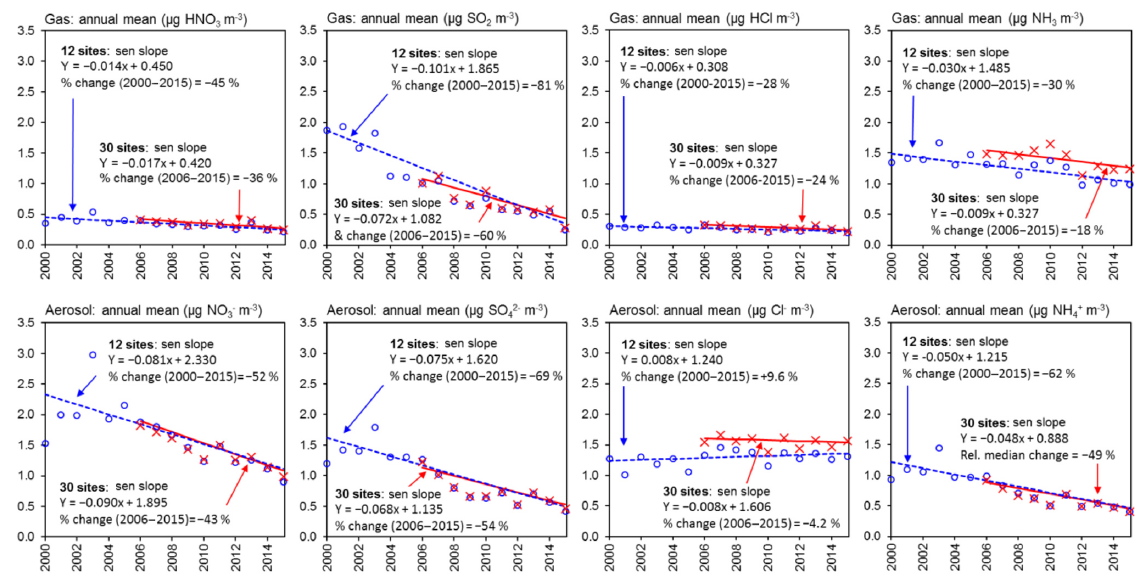
Figure 15. Time series trend analysis by non-parametric Mann–Kendall Sen slope on annually averaged gas and aerosol concentration data from the UK Acid Gases and Aerosol Monitoring Network (AGANet) of (i) 12 sites with complete time series over the period 2000–2015 and (ii) expanded 30 sites with complete times series over the period 2006–2015. NH 3 and NH + time in the UK National Ammonia Monitoring Network (NAMN, Tang et al., 2018) are also included for